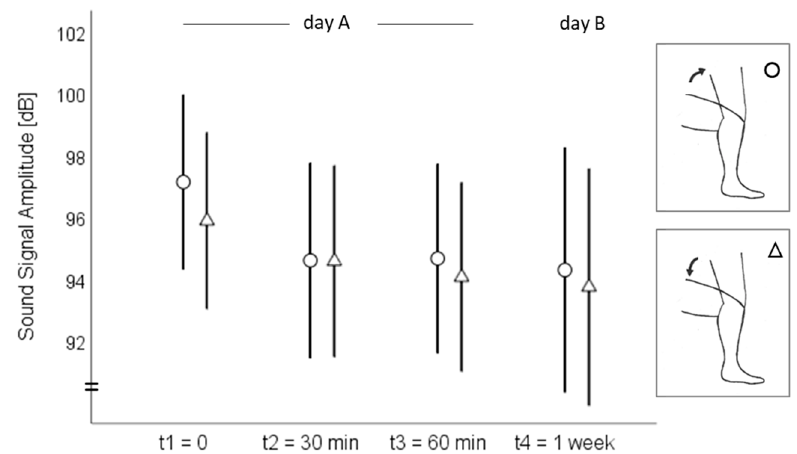
Figure 3. Means and 95% confidence intervals of the sound signal amplitude (dB) at the patella during standing up (circles) and sitting down (triangles).